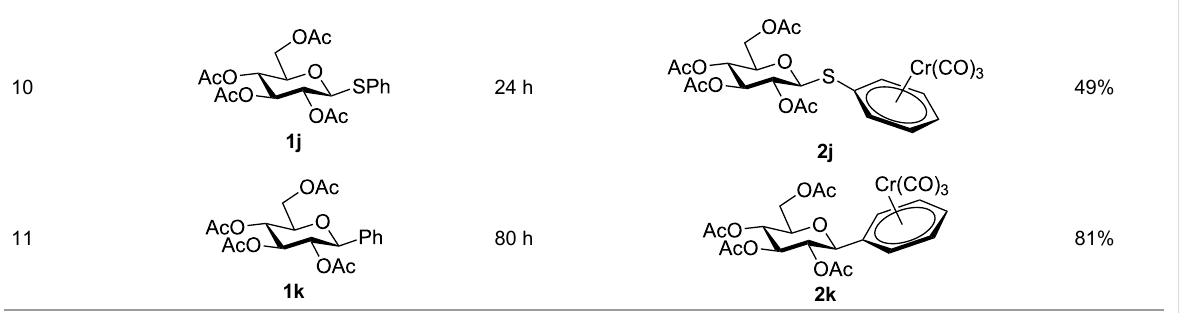
Table 1: Synthesis of η 6 -tricarbonylchromium complexes 2a – k from glycosides 1a – k and Cr(CO) 6 in di- n -butylether/THF 9:1 at 140 °C under Ar and exclusion of light.